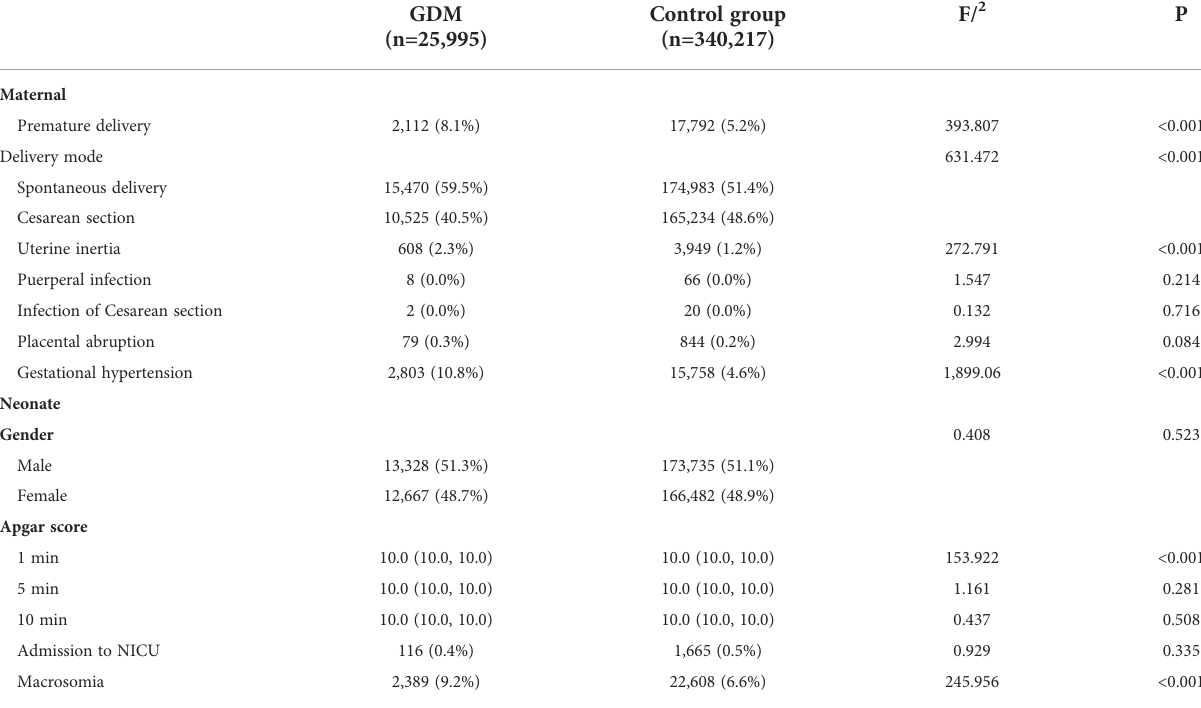
TABLE 2 Adverse outcome of individuals with GDM in Hebei from 2014 to 2021.